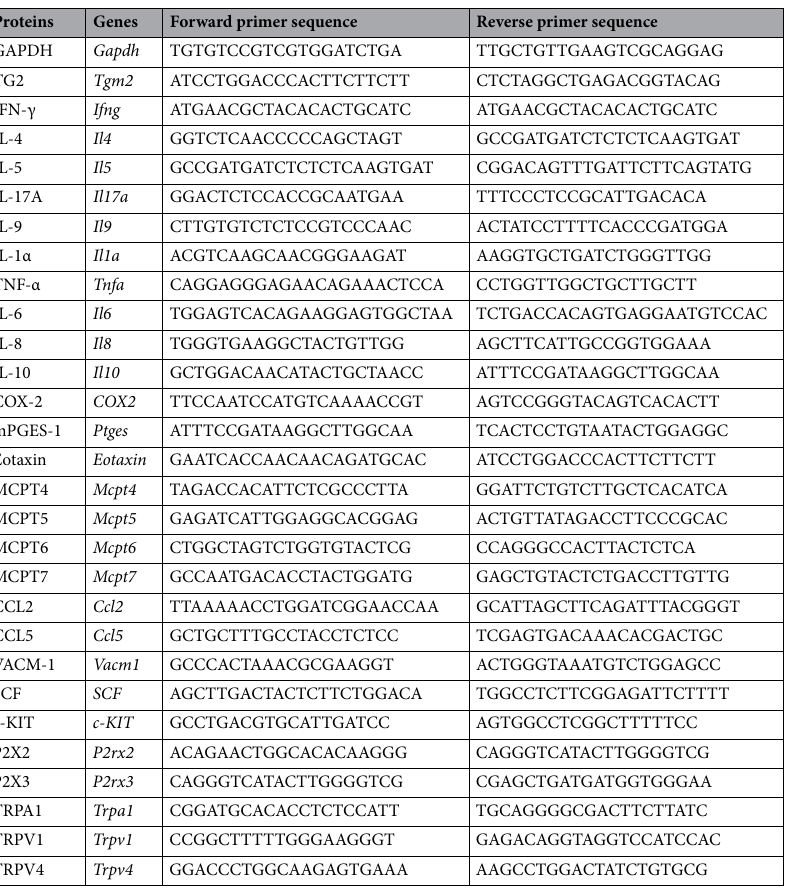
Table 2. Primer pairs’ sequences of mice genes used in RT-qPCR. GAPDH, glyceraldehyde-3-phosphate dehydrogenase; IFN, interferon; TNF, tumor necrosis factor; COX, cyclooxygenase; mPGES-1, microsomal prostaglandin E synthase-1; Ptges, prostaglandin E synthase; Mcpt, mast cell protease; VACM-1, vascular cell adhesion molecule-1; SCF, stem cell factor; c-KIT, receptor tyrosine